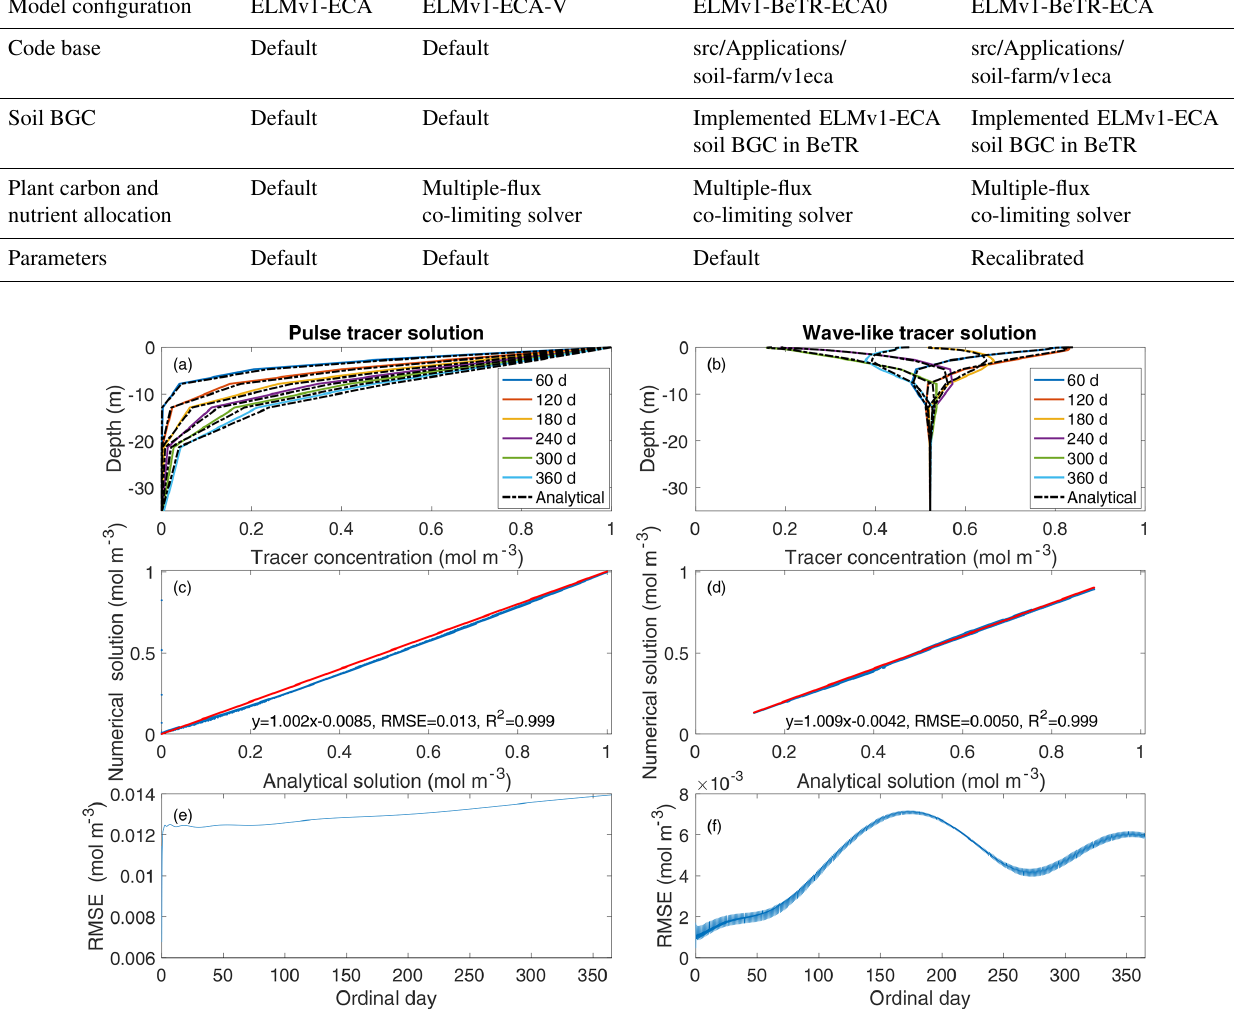
Figure 1. Comparison of the analytical solutions with the numerical solutions derived from BeTR-v2. Panels (a) and (b) are comparisons of simulated and analytical tracer concentrations sampled at the end of 6 different days. In panels (c) and (d) , blue dots are plotted using analytical solutions on the x axis and numerical solutions on the y axis; red lines are linear regressions of these data. Panels (e) and (f) are the depth-averaged root-mean-square error (RMSE) through